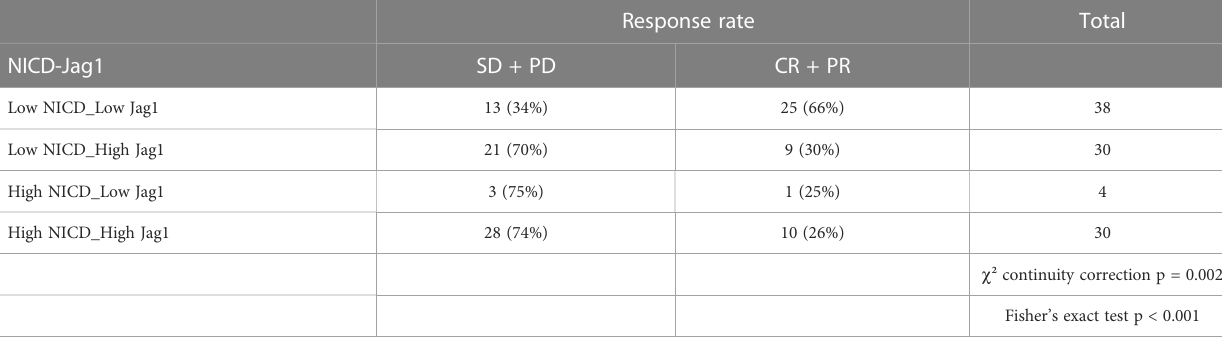
TABLE 3 Response according to NICD and Jag1 protein expression.